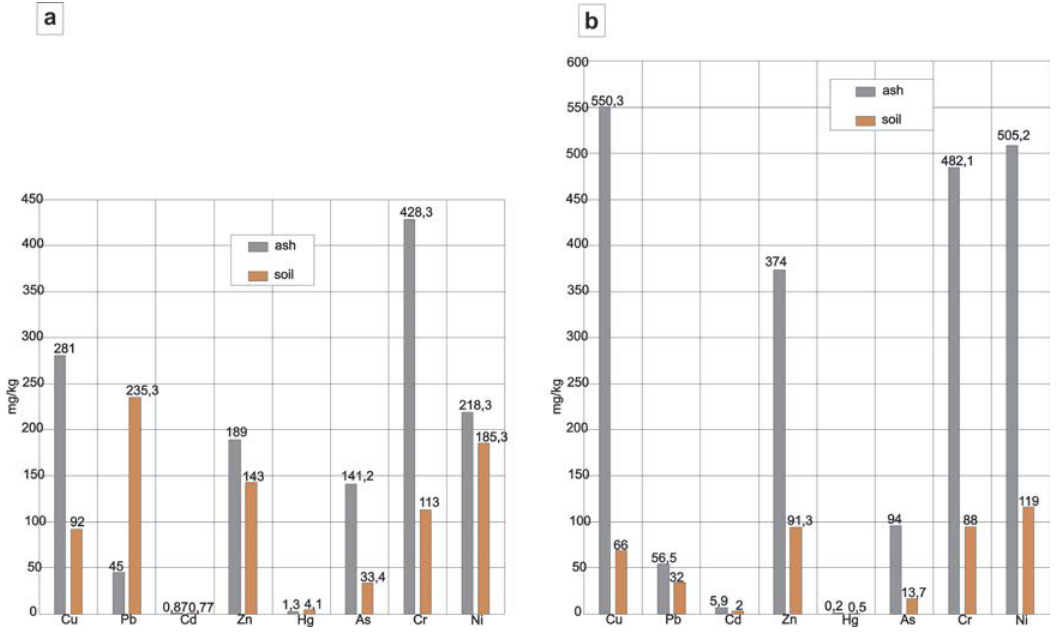
Figure 5. Comparative bar graph of maximum concentrations of elements analyzed in the ash and soil: ( a ) in the area surrounding the Kostolac coal basin; ( b ) in the area surrounding the Gacko coal basin.